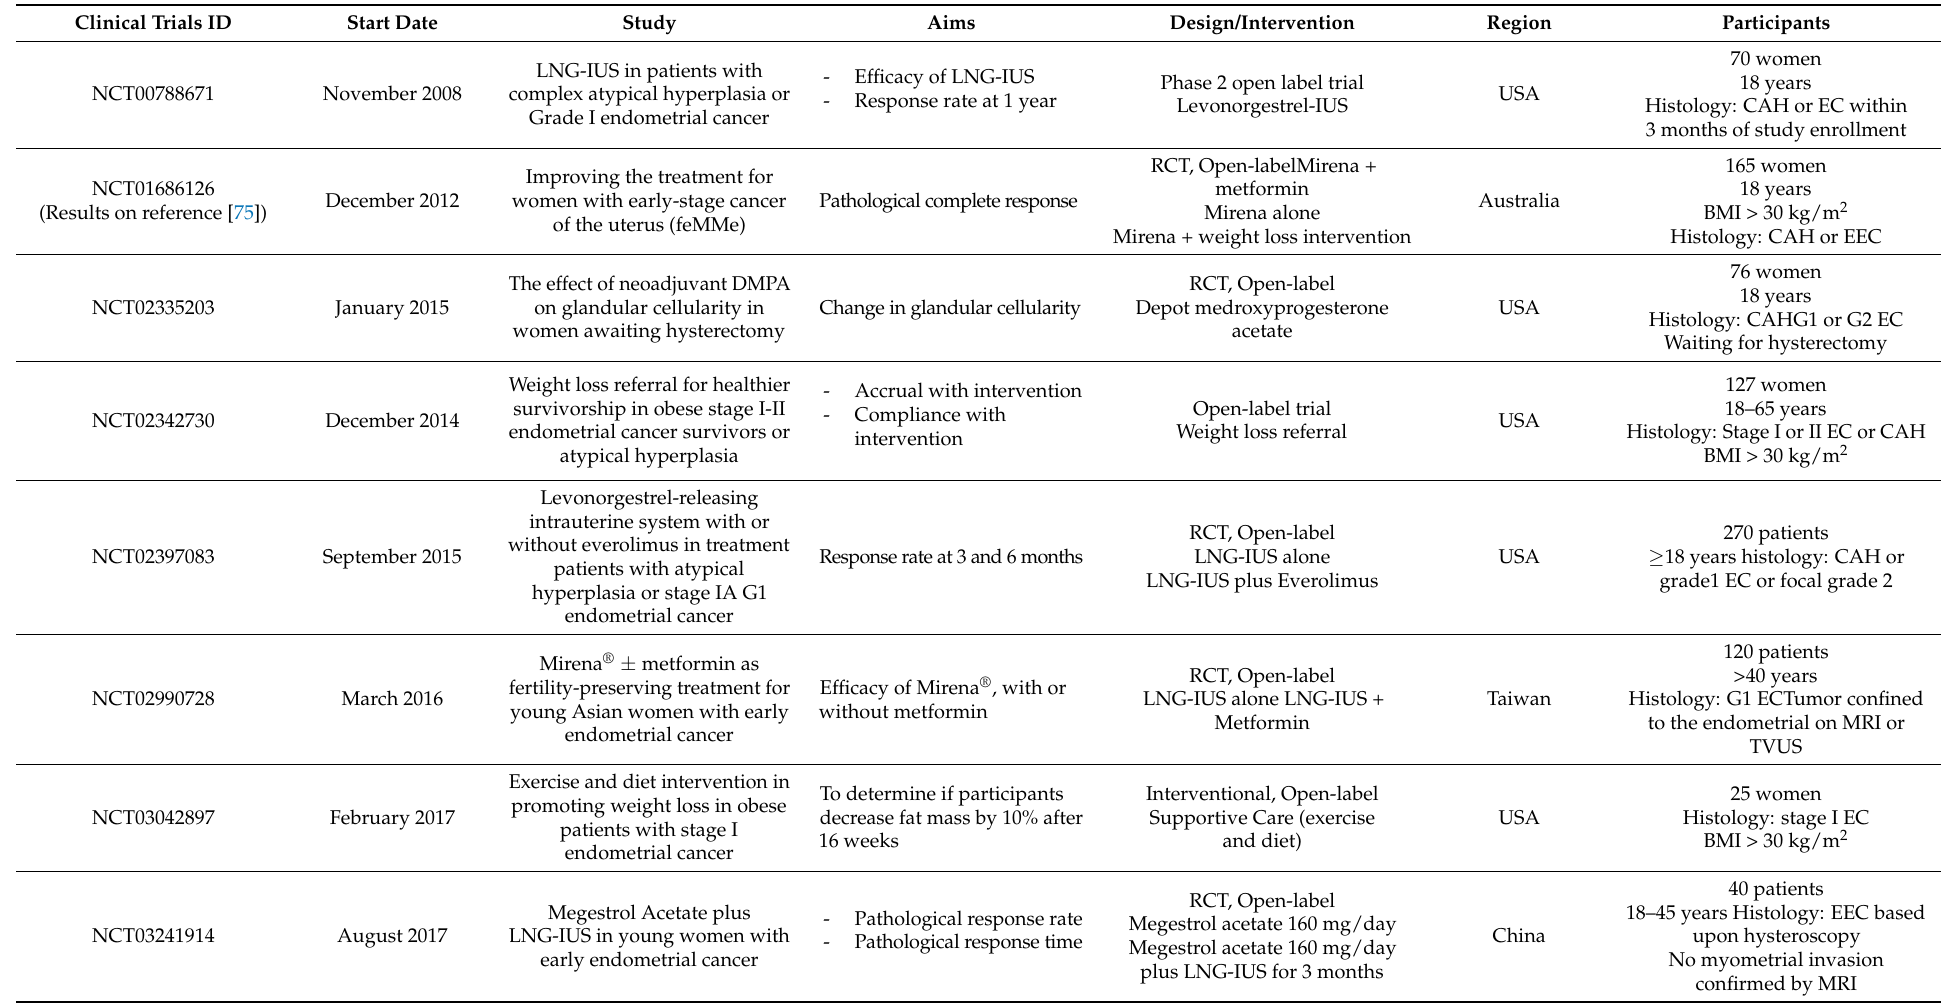
Table 4. Ongoing clinical trials of conservative treatment for endometrial cancer